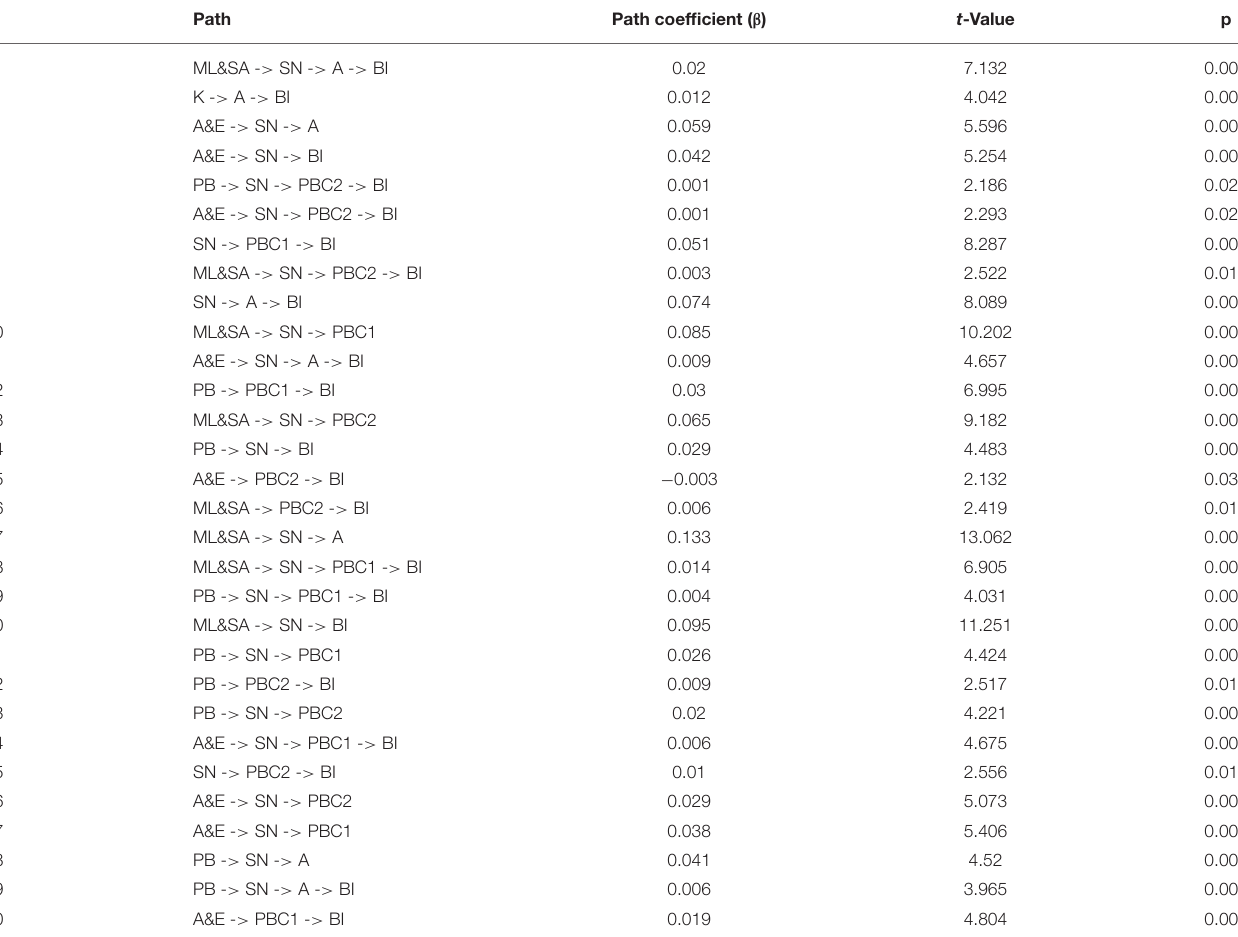
TABLE 5 | Specific indirect effects ( n =